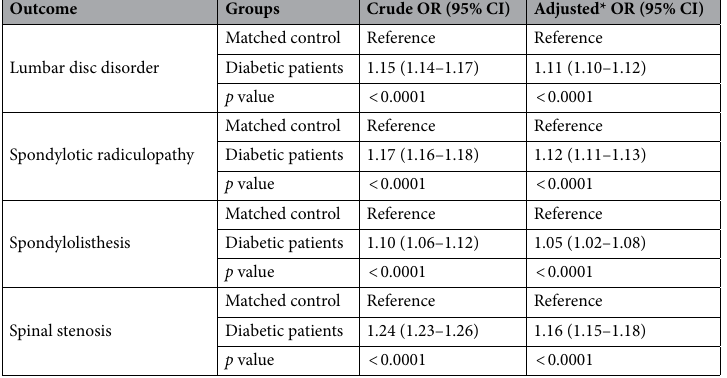
Table 2. Association of type 2 diabetes with lumbar disc disorder, spondylotic radiculopathy spondylolisthesis, and spinal stenosis. OR Odds ratio, CI Confidence interval. *Adjusted by age, sex, type of beneficiary, hypertension, chronic kidney disease, and dyslipidemia.